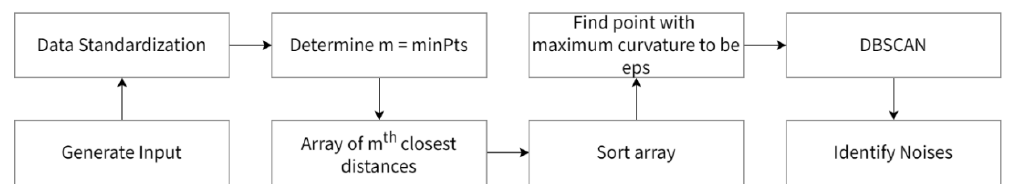
Figure 6. Flowchart of the proposed clustering algorithm.